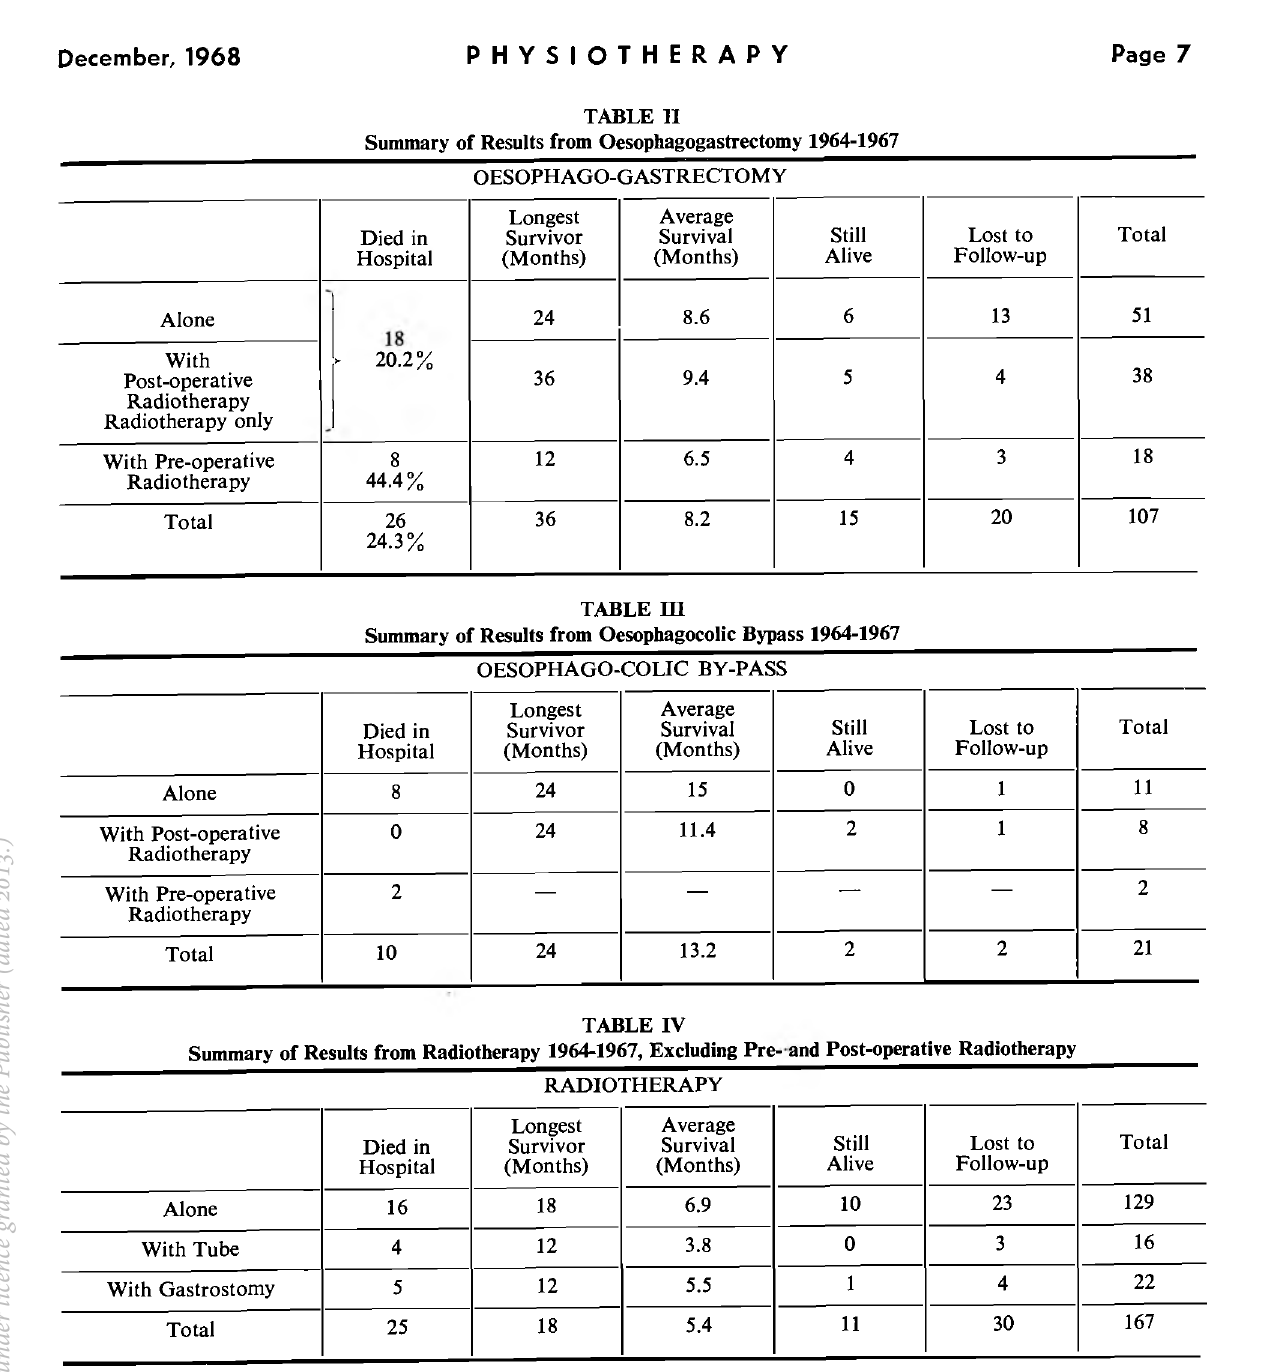
Summary of Results from Intubation